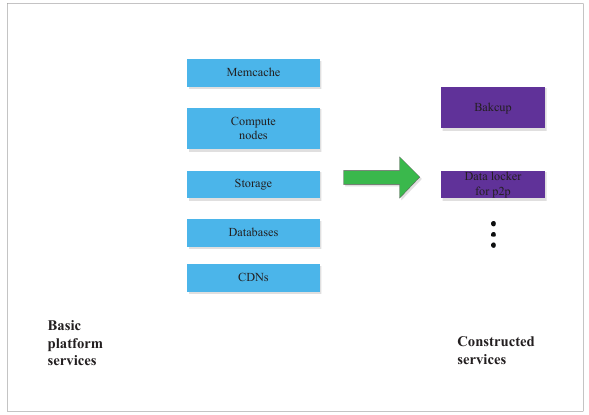
Figure 3. Platform services